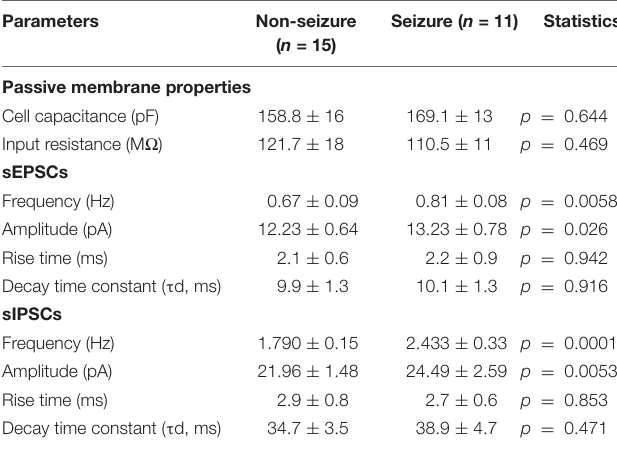
TABLE 2 | Passive membrane properties and characteristics of spontaneous excitatory postsynaptic currents (sEPSCs) and spontaneous inhibitory postsynaptic currents (sIPSCs) recorded from pyramidal neurons in non-seizure and with seizure samples obtained from low-grade glioma